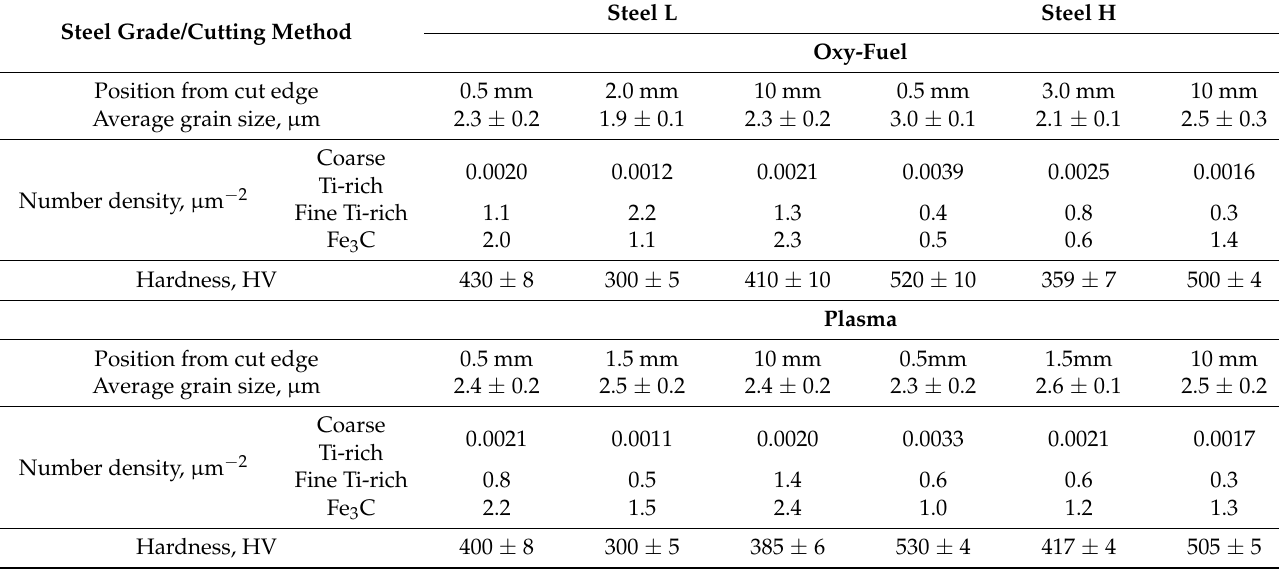
Table 6. Correlation of the microstructural parameters and hardness to steel grade and cutting method. Steel Grade/Cutting